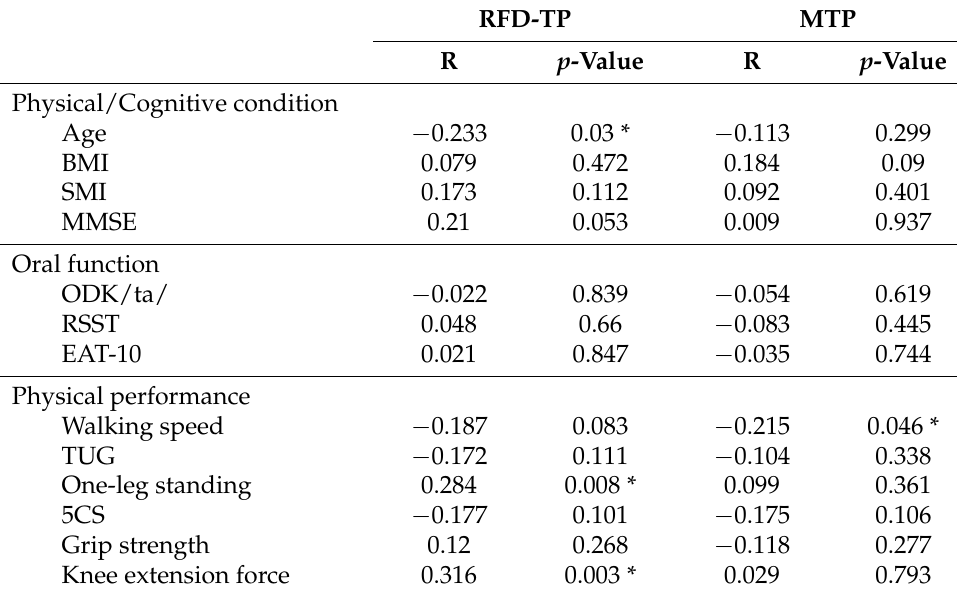
Table 2. Correlations between RFD or MTP and evaluated